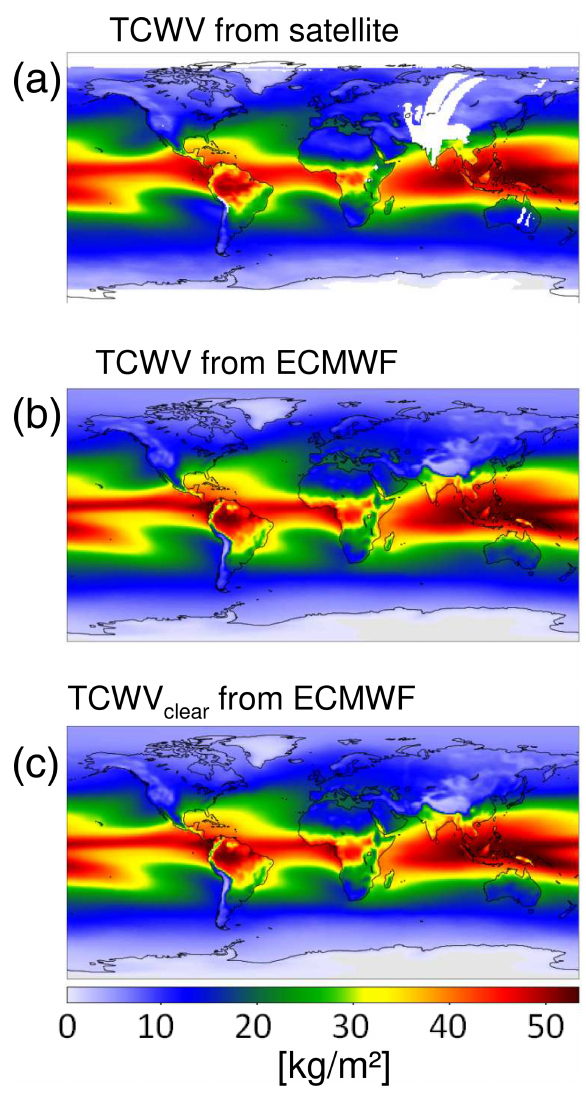
Figure 2. Global mean distribution of the TCWV from satellite ob- servations (a) and ERA data: (b) all data; (c) only clear sky obser- vations during